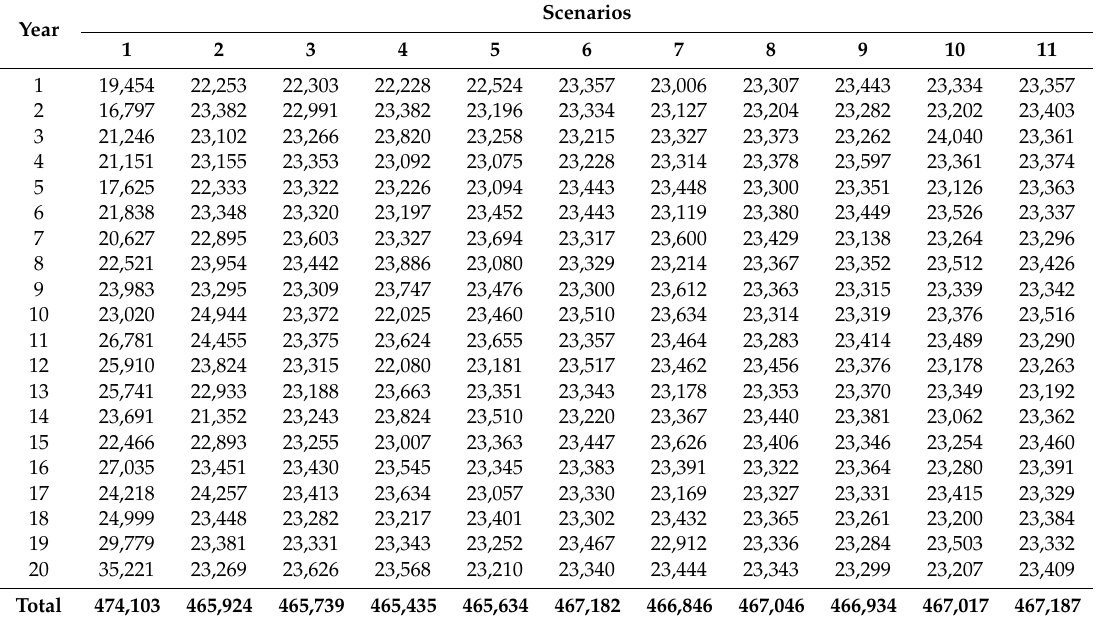
Table 7. Volume (m 3 ) scheduled for harvest for all scenarios when using the regeneration